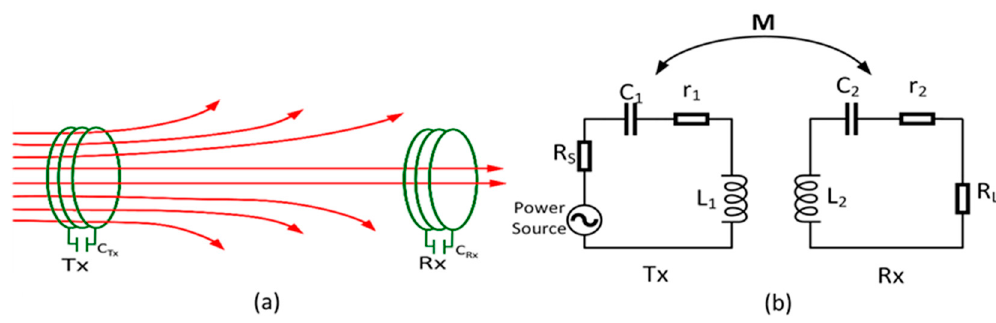
Figure 1. ( a ) The conventional radio frequency energy transfer system without relay resonator and ( b ) its equivalent circuit model.